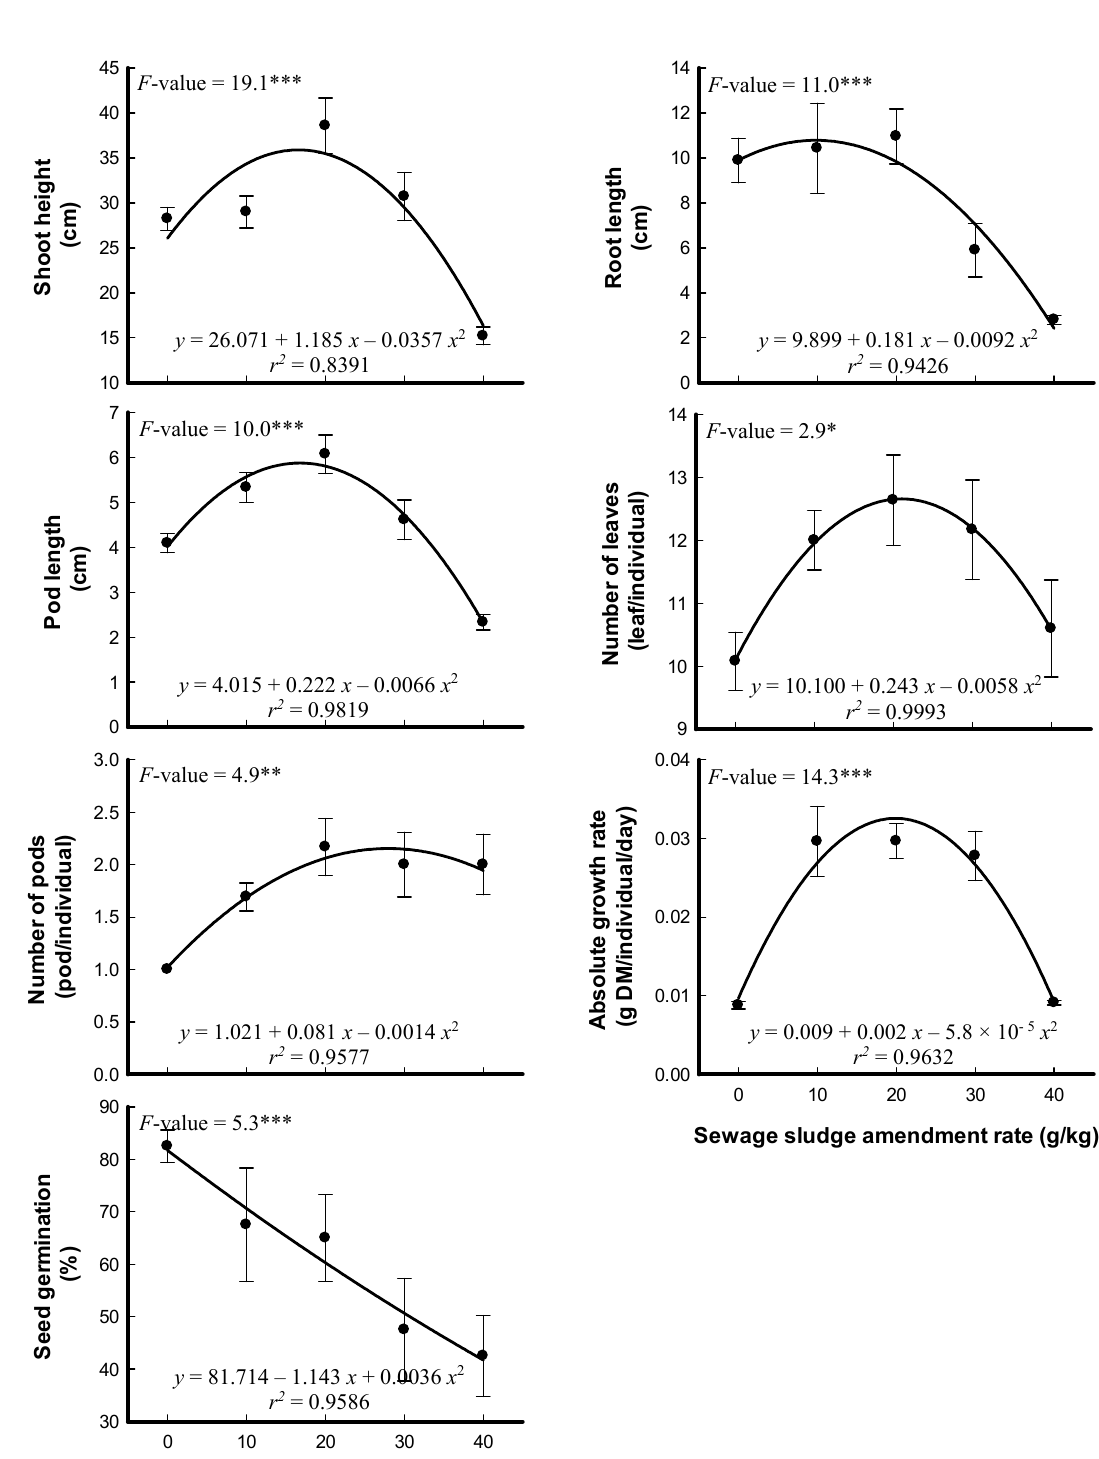
Figure 2. Effects of different sewage sludge amendment rates on the morphometric parameters of Pisum sativum that had been grown for 57 days (means ± standard error, n = 6). The F -values represent one-way analysis of variance (ANOVA) and a degree of freedom ( df ) = 4. *: p < 0.05, **: p < 0.01, ***: p < 0.001.